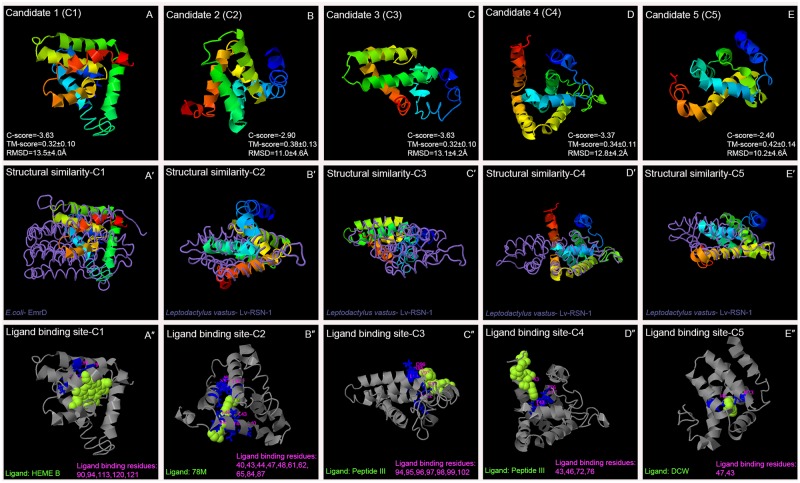
Three-dimensional structure of novel Newt proteins and their predicted function.Using I-TASSER server (A-E) Three-dimensional structure of novel Newt proteins (A'-E') Structural similarity to already submitted proteins from PDB library (Query structure is shown in the cartoon, while the structural analog is displayed using backbone trace), and (A''-E'') ligand that has highest probability to bind to the ligand site in the protein are predicted.